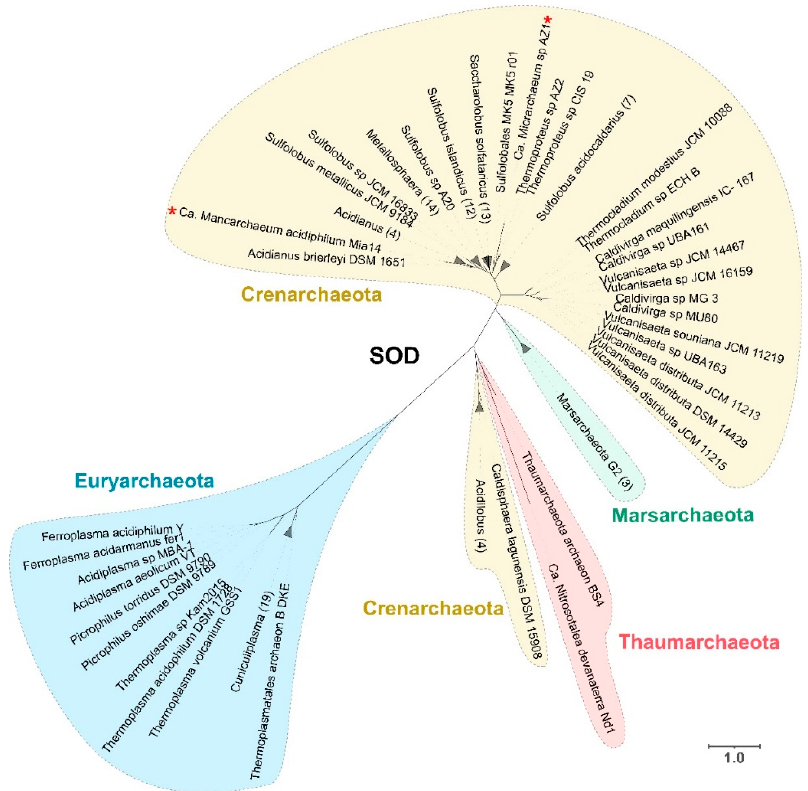
Figure 2. Superoxide dismutase phylogenetic tree from predicted protein sequences for gene sod A. Two Candidatus Micrarchaeota leaves are marked with red asterisks, which are in the bigger clade of Crenarchaeota. Colors represent different phyla associations, with yellow for Crenarchaeota, red for Thaumarchaeota, green for Marsarchaeota and blue for Euryarchaeota. Scale bar represents 1 amino acid substitution per site.